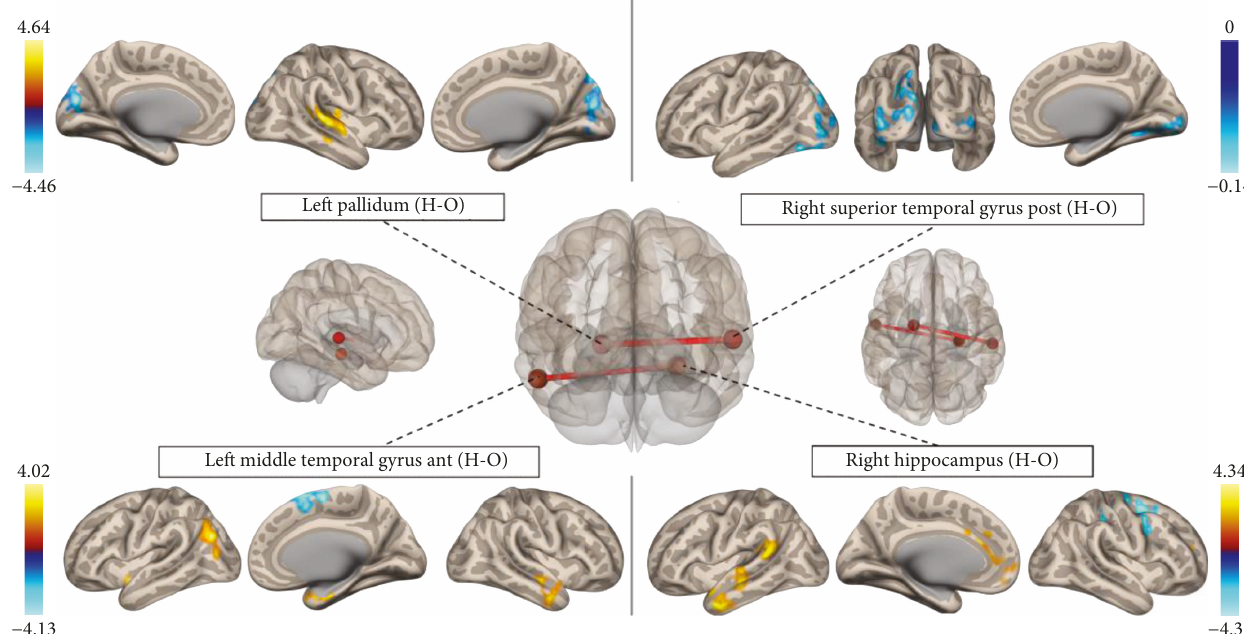
Figure 4: Resting state functional connectivity di ff erences between groups. ROI-to-ROI analyses revealed a positive correlation in the left pallidum-right superior temporal gyrus post and right hippocampus-left middle temporal gyrus ant connections (centre). Increase (red) or decrease (blue) in seed-to-voxel connectivity maps for each node is shown for the threshold ( p < 0 05 , FDR corrected). An unthresholded pattern activation is shown in Figure S2, supplementary materials. All voxels with signi fi cant connectivity changes are shown in the fi gure and listed in Table S1, supplementary materials. Note: H-O: